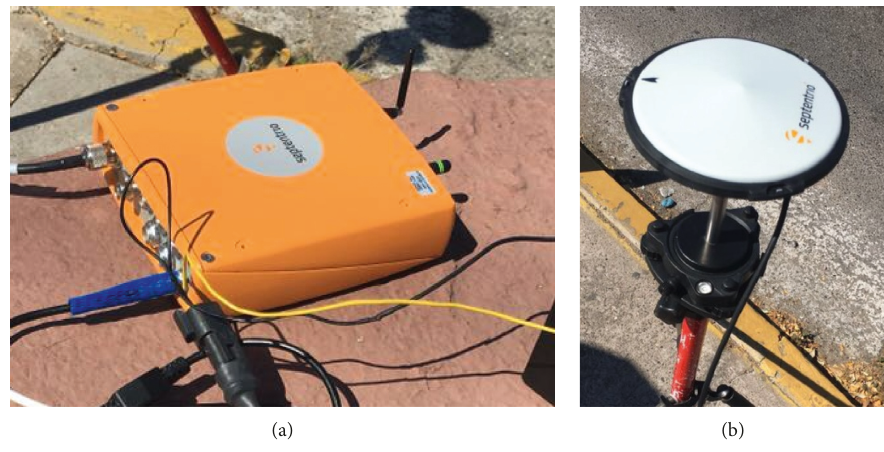
Figure 1: GPS sensors used: (a) receiver unit; (b)